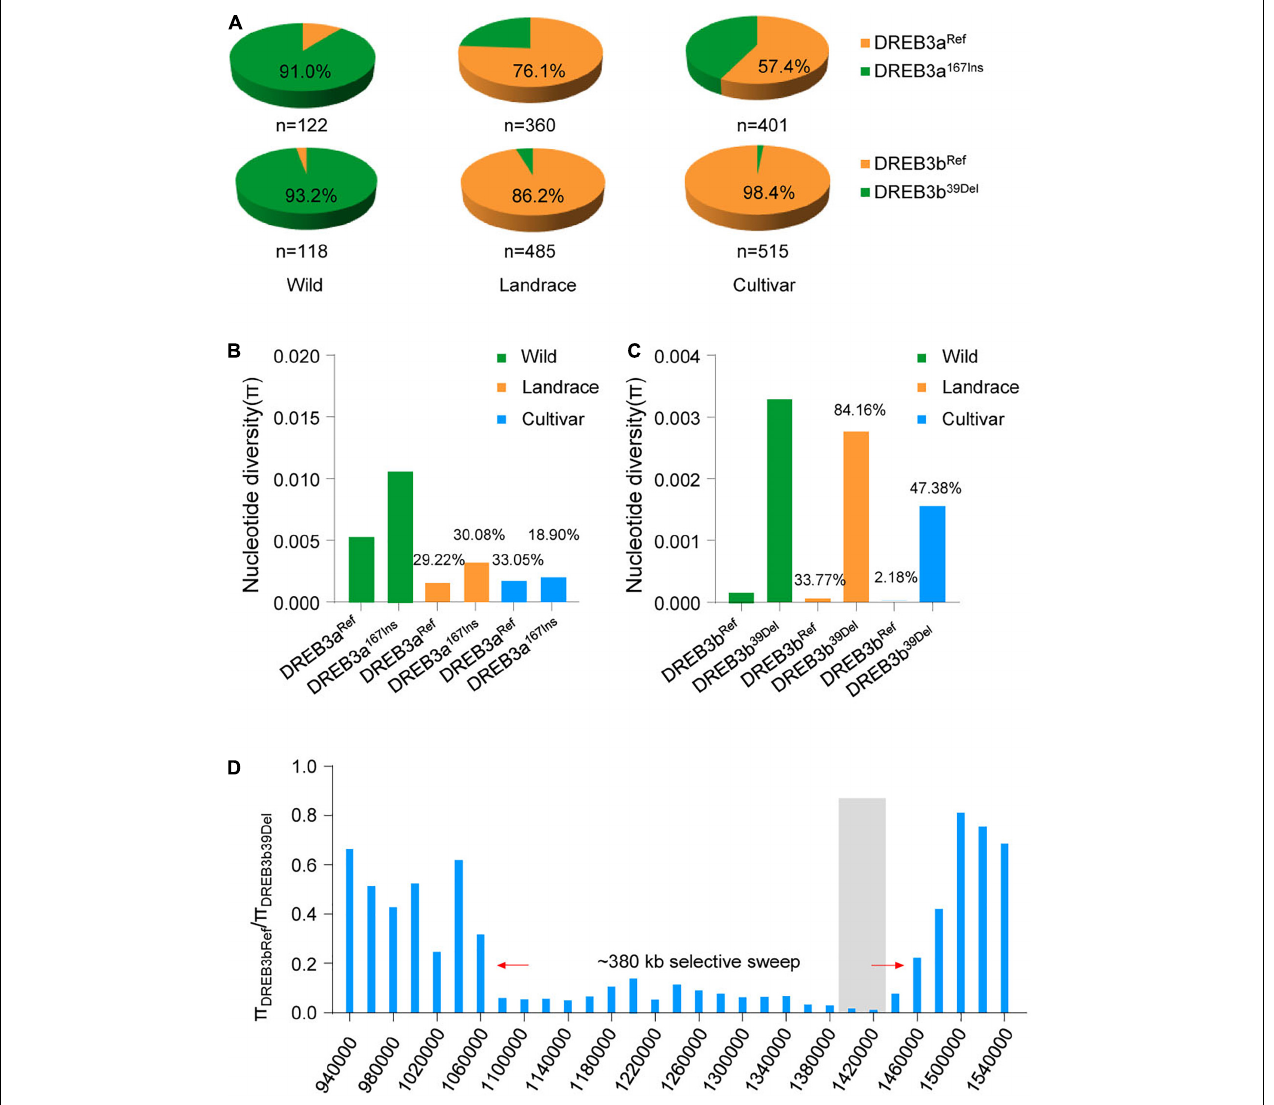
FIGURE 5 | DREB3b underwent artificial selection but DREB3a did not. (A) Proportions of DREB3a and DREB3b alleles and their co-occurrence with each of the three germplasm groups (wild, landrace, and cultivar). (B) Nucleotide diversity analysis of the region surrounding DREB3a in wild, landrace, and cultivated soybean. (C) Nucleotide diversity analysis of the region surrounding DREB3b in wild, landrace, and cultivated soybean. (D) Selective sweep in the 380-kb DREB3b genomic